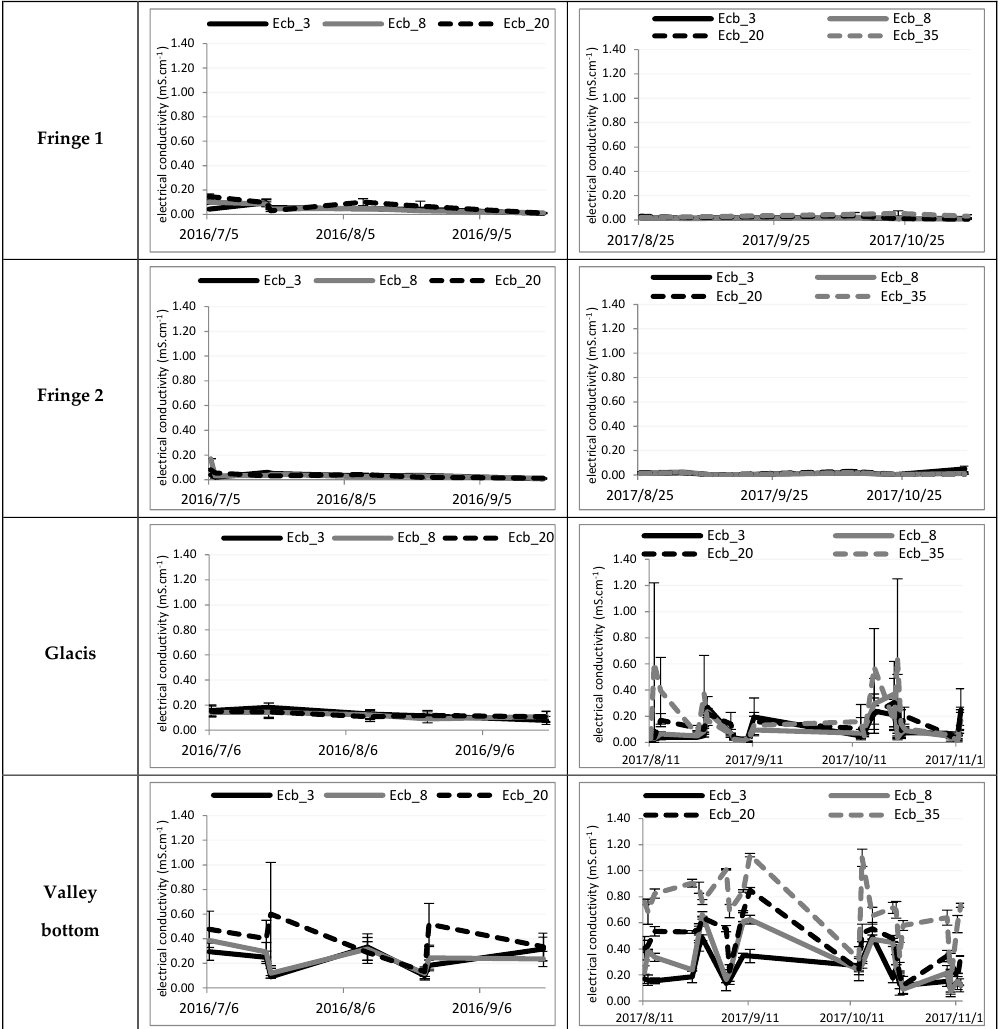
Figure 6. Soil bulk conductivity at different soil depths during the 2016 and 2017 growing seasons. Error bars indicate the standard errors of the mean.